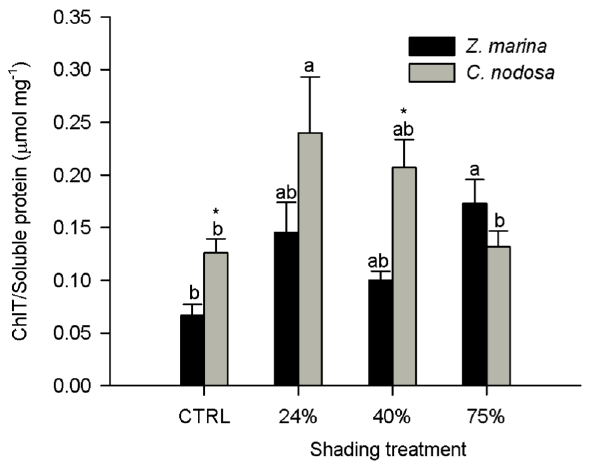
Figure 2. Total chlorophyll to soluble protein ratio (ChlT/ Protein) in leaves of Zostera marina and Cymodocea nodosa. Plants submitted to shading treatments of 24, 40 and 75% of naturally available photosynthetically active radiation (CTRL). Different letters indicate significant differences between treatments, * indicates differences between species (n=5, p ,